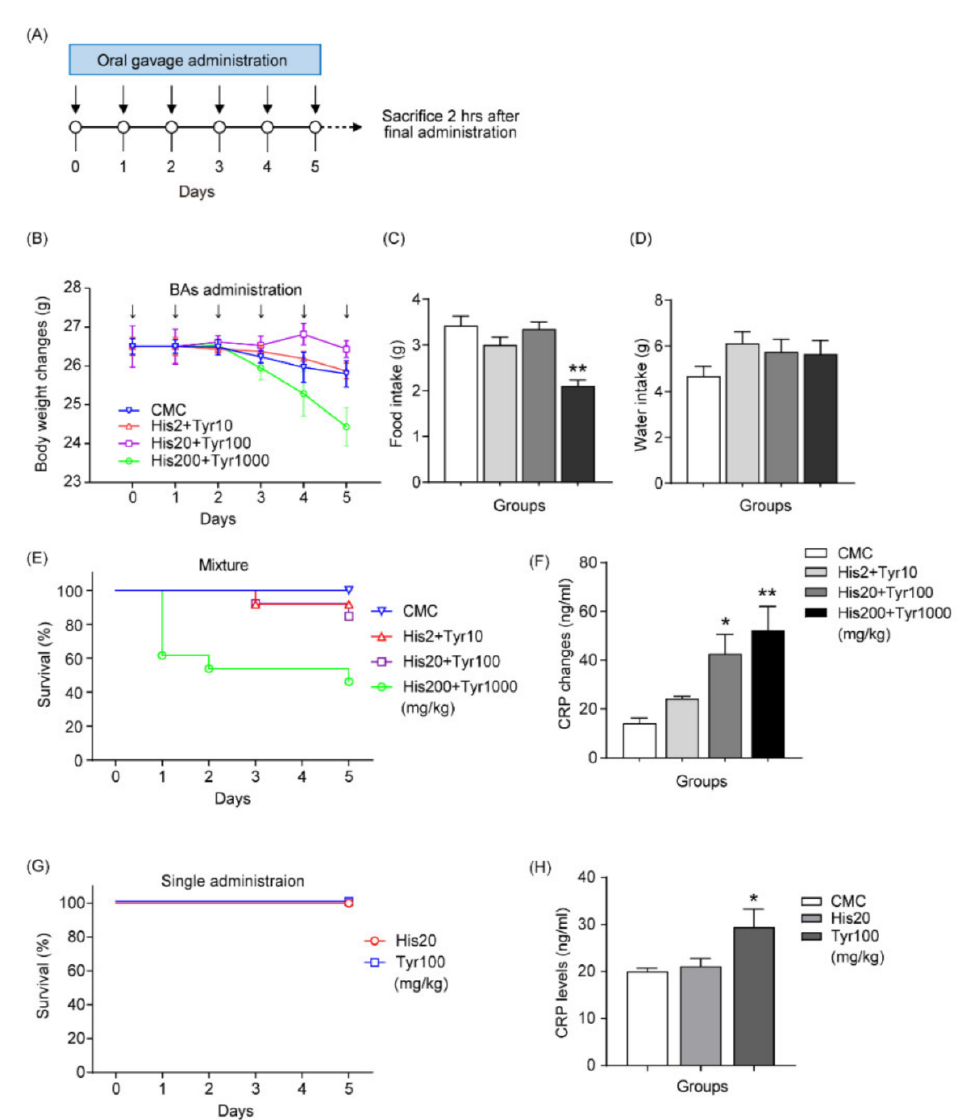
Figure 1. Combined effect of biogenic amines administered by repeated oral gavage in mice fed a normal chow diet (NCD). ( A ) Timeline of repeated oral gavage administrations of biogenic amines. Changes in body weight ( B ), food intake ( C ), and water intake ( D ) after repeated oral gavage admin- istrations of biogenic amines. ( E ) Changes in survival rate after repeated oral gavage administrations of biogenic amines by concentration. ( F ) Changes in plasma C-reactive protein (CRP) levels after repeated oral gavage administrations of biogenic amines by concentration. ( G ) Changes in survival rate following repeated oral gavage administration of histamine and tyramine. ( H ) Changes in plasma CRP levels after repeated oral gavage administrations of either histamine or tyramine. * p < 0.05, ** p < 0.01 vs. carboxymethylcellulose (CMC). Data are shown as mean ± SEM. BA, biogenic amine; His, histamine; Tyr,